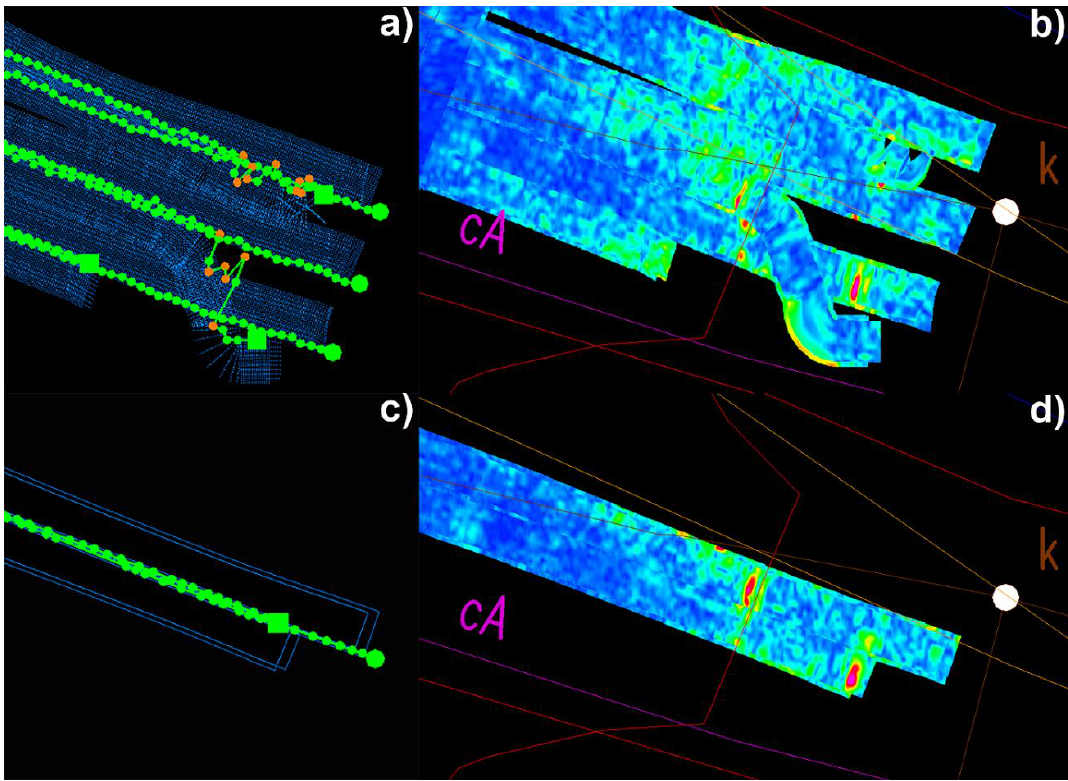
Figure 16. Comparison of trajectories obtained in limited horizon conditions by ( a , b ) GPS PPS and ( c , d ) total station.